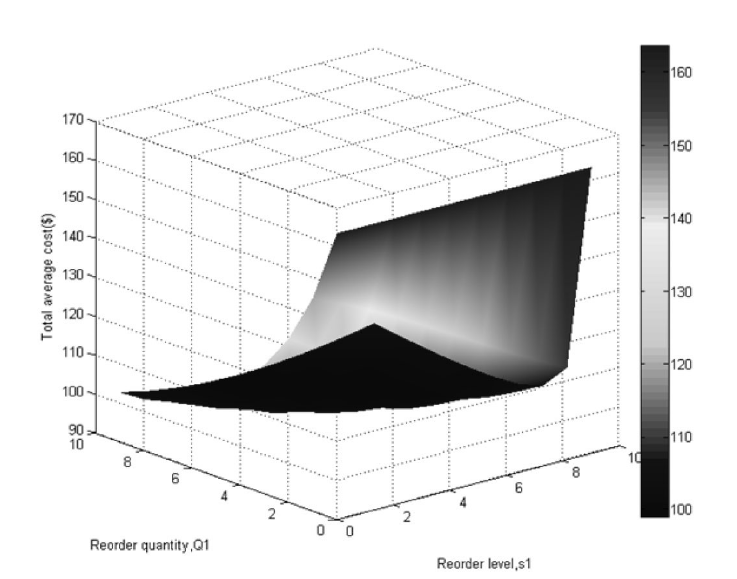
Figure 4. Total average cost function for warehouse 1(Example